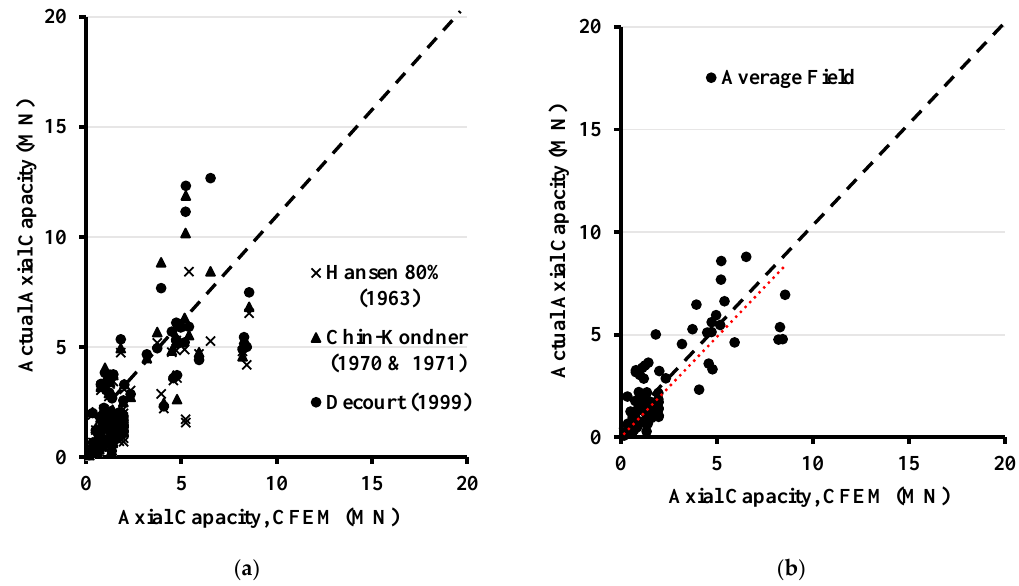
Figure 1. Comparison between results of other design codes and the theoretical axial capacity in driven piles determined using the CFEM method.